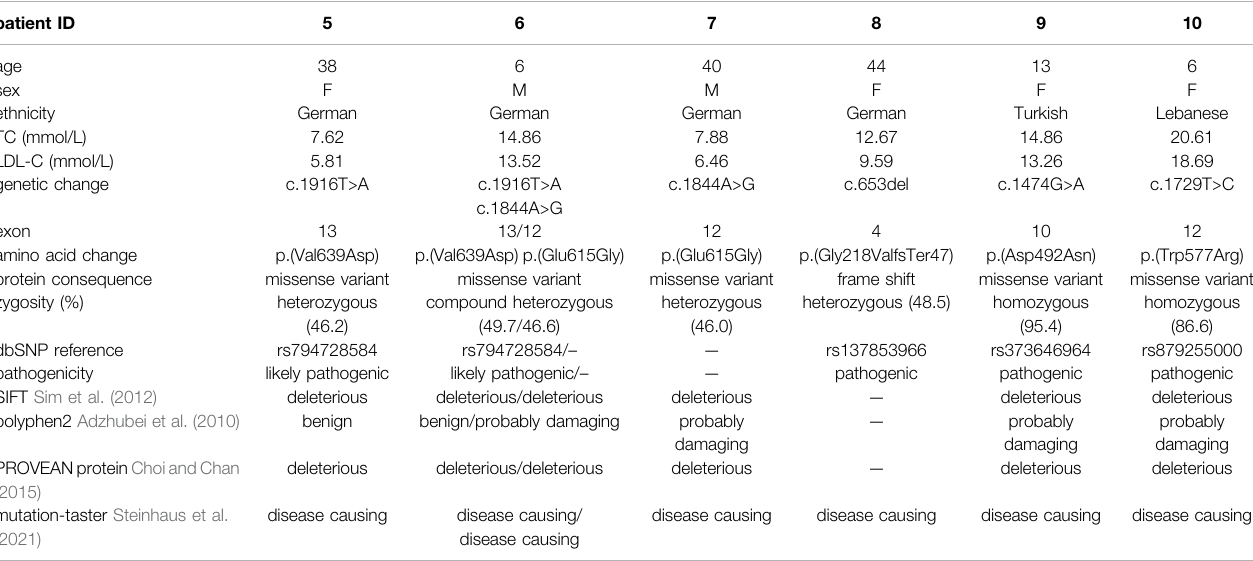
TC, total cholesterol; LDL-C, low-density lipoprotein cholesterol; CDS, coding sequence. TABLE 2 | Identi fi cation of unknown variants in patients with suspected